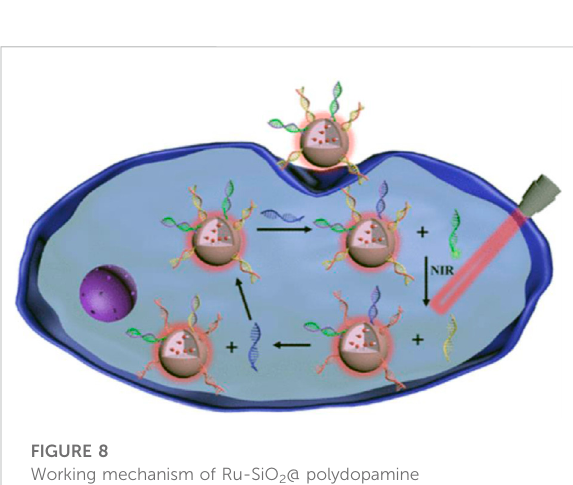
FIGURE 8 Working mechanism of Ru-SiO 2 @ polydopamine nanoplatform for MicroRNA detection in cells (Deng et al., 2021). Copyright 2021 American Chemical